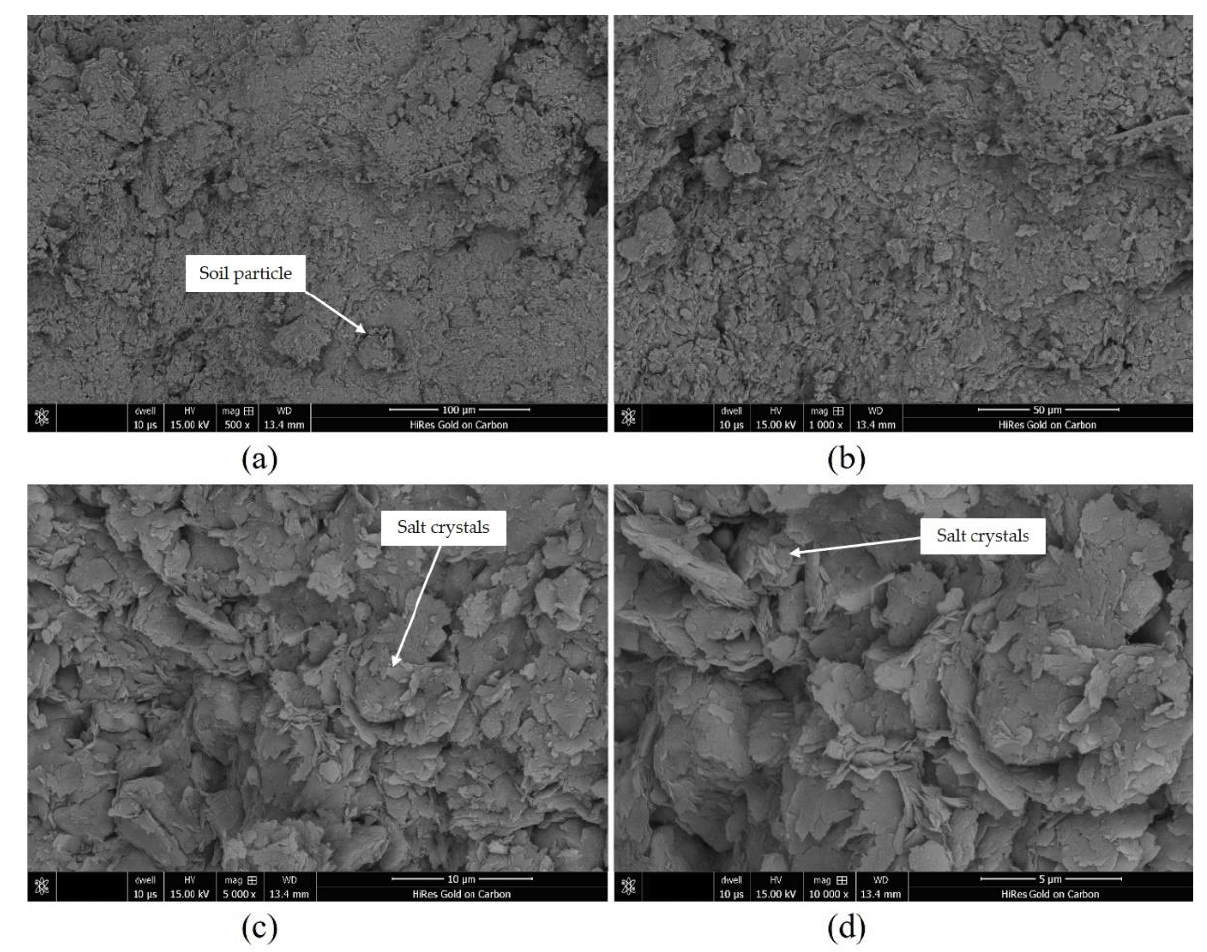
Figure 5. SEM images of the unfrozen specimens (S = 2.1%) with different magnifications. Notes: ( a ) 500 × image; ( b ) 1000 × image; ( c ) 5000 × image; and ( d ) 10,000 × image.